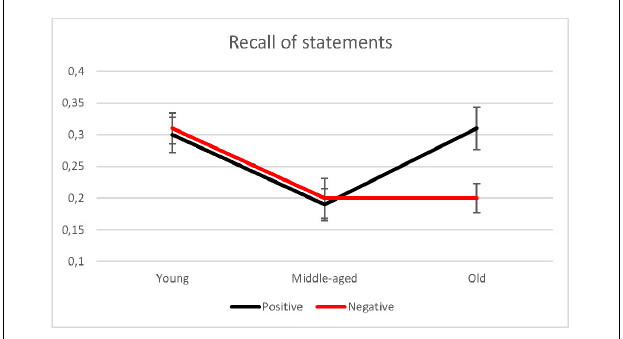
FIGURE 1 | Recall of positive and negative statements in young, middle-aged, and older